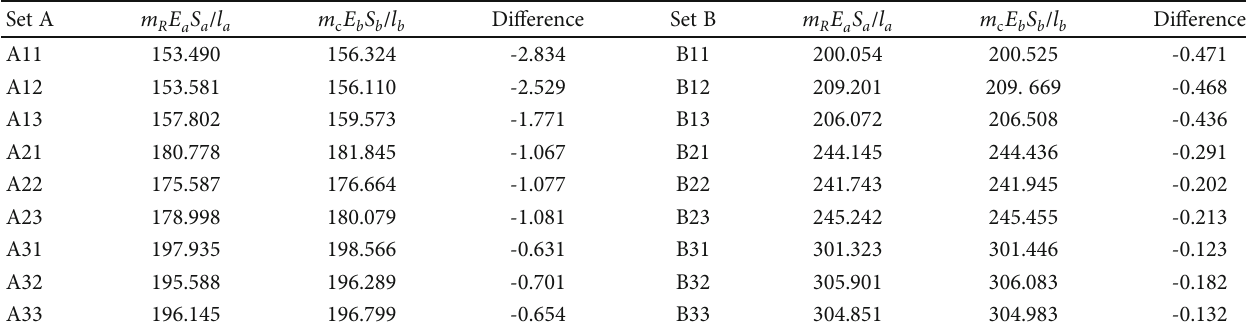
Figure 10: The failure modes of the coal – rock combination sample structures with di ff erent height ratios: (a) siltstone-coal height ratio 1 :1; (b) siltstone-coal height ratio 1.5 :1; (c) siltstone-coal height ratio 2 :1. Table 2: The critical equilibrium values for the failure of the two types of coal – rock combination sample structures with di ff erent lithologies and di ff erent height